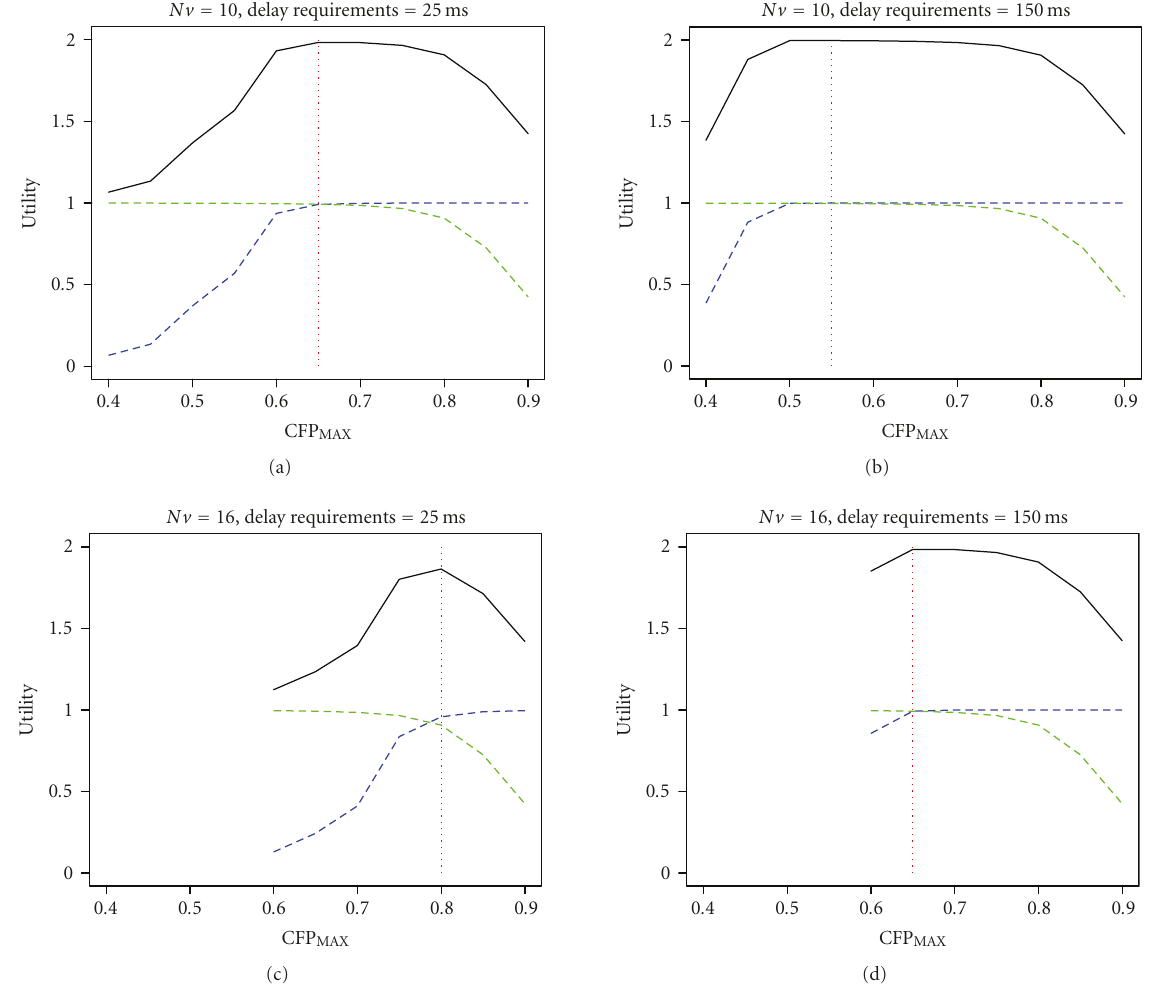
Figure 14: Objectives for a set of di ff erent network sizes and delay requirements. The blue dotted line shows the polled tra ffi c utility, the green gives the data utility. The black line is the combined objective; red dotted line is the optimum CFP MAX